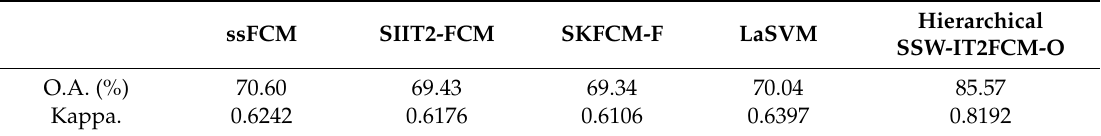
Figure 16. Classification results of five methods when the sample size was reduced to 8%. Table 9. The overall accuracy and Kappa coefficients of the results of five methods if the sample size is reduced to 6%.